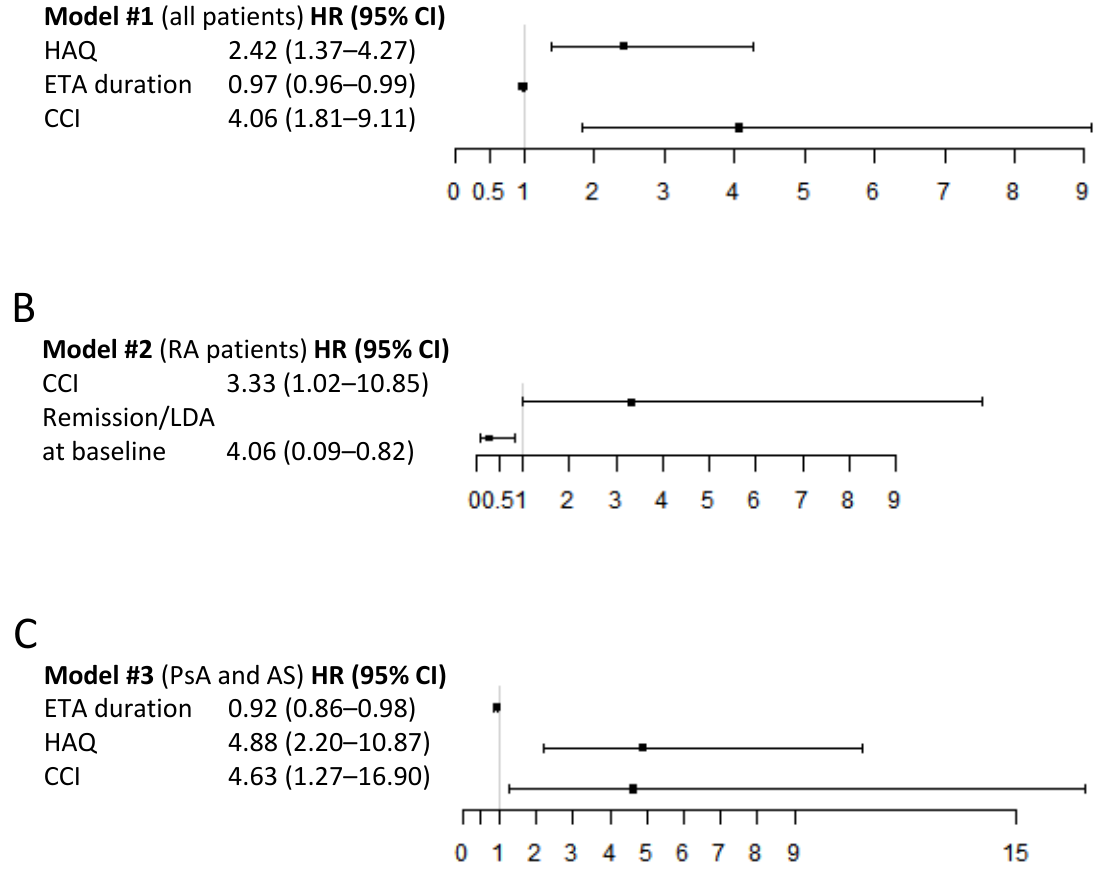
Figure 3. Forest plots showing predictive variables of maintaining the response after switch from ETA to SB4. ( A ), Model#1 including all patients, ( B ), Model#2 stratified for RA patients and ( C ), Model#3 in patients who were seronegative (i.e., PsA and AS patients). Data presented as hazard ratio (HR) and 95% confidence intervals (CI). CCI = Charlson Comorbidity Index; HAQ = Health Assessment Questionnaire; PsA = psoriatic arthritis; RA = rheumatoid arthritis.